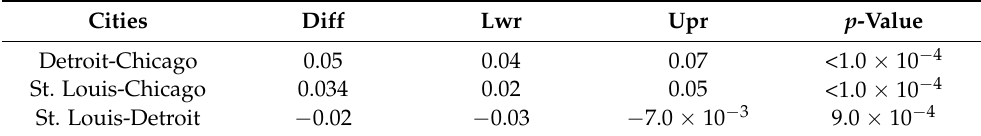
Table 2. Results of a Tukey HSD post hoc analysis reveal significant differences in the average tem- perature in 2016 between St. Louis and Chicago and between St. Louis and Detroit.